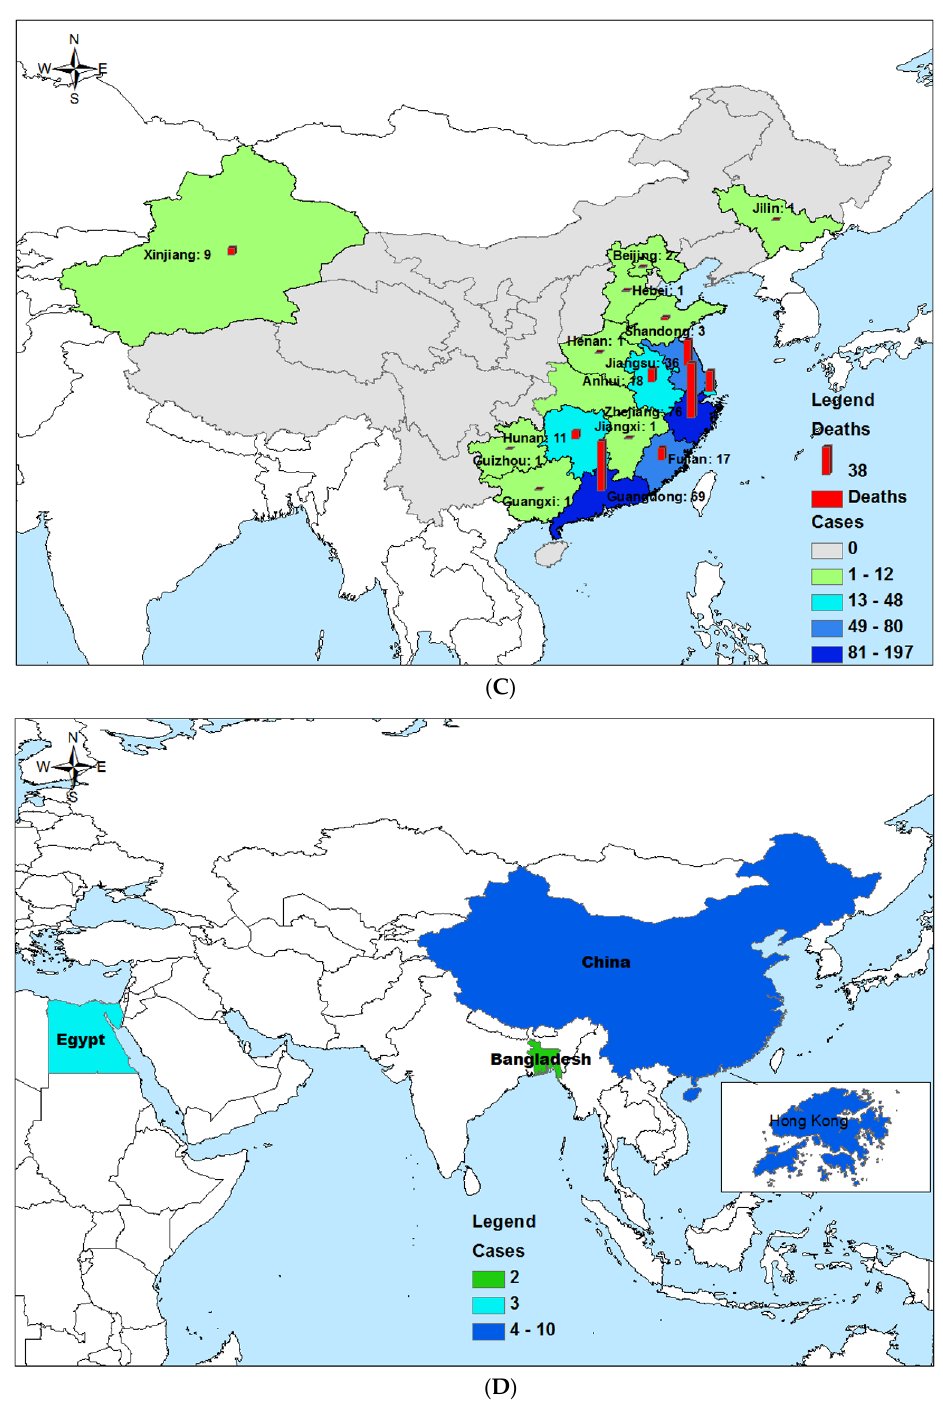
Figure 1. The geographic distribution of the total number of highly pathogenic avian influenza A (H5N1 and H5N6) and low pathogenic A (H7N9 and H9N2) virus cases and deaths until November of 2016. The shadow and the bar in the map were generated by the number of total cases and the deaths, respectively. ( A ) Highly pathogenic avian influenza A (H5N1): total human cases (N = 638) and deaths (N = 379). ( B ) Highly pathogenic avian influenza A (H5N6): total human cases (N = 16) and deaths (N = 11). ( C ) Low pathogenic avian influenza A (H7N9): total human cases (N = 676) and deaths (N = 275). ( D ) Low pathogenic avian influenza A (H9N2): total human cases (N = 21) and deaths (N = 0).